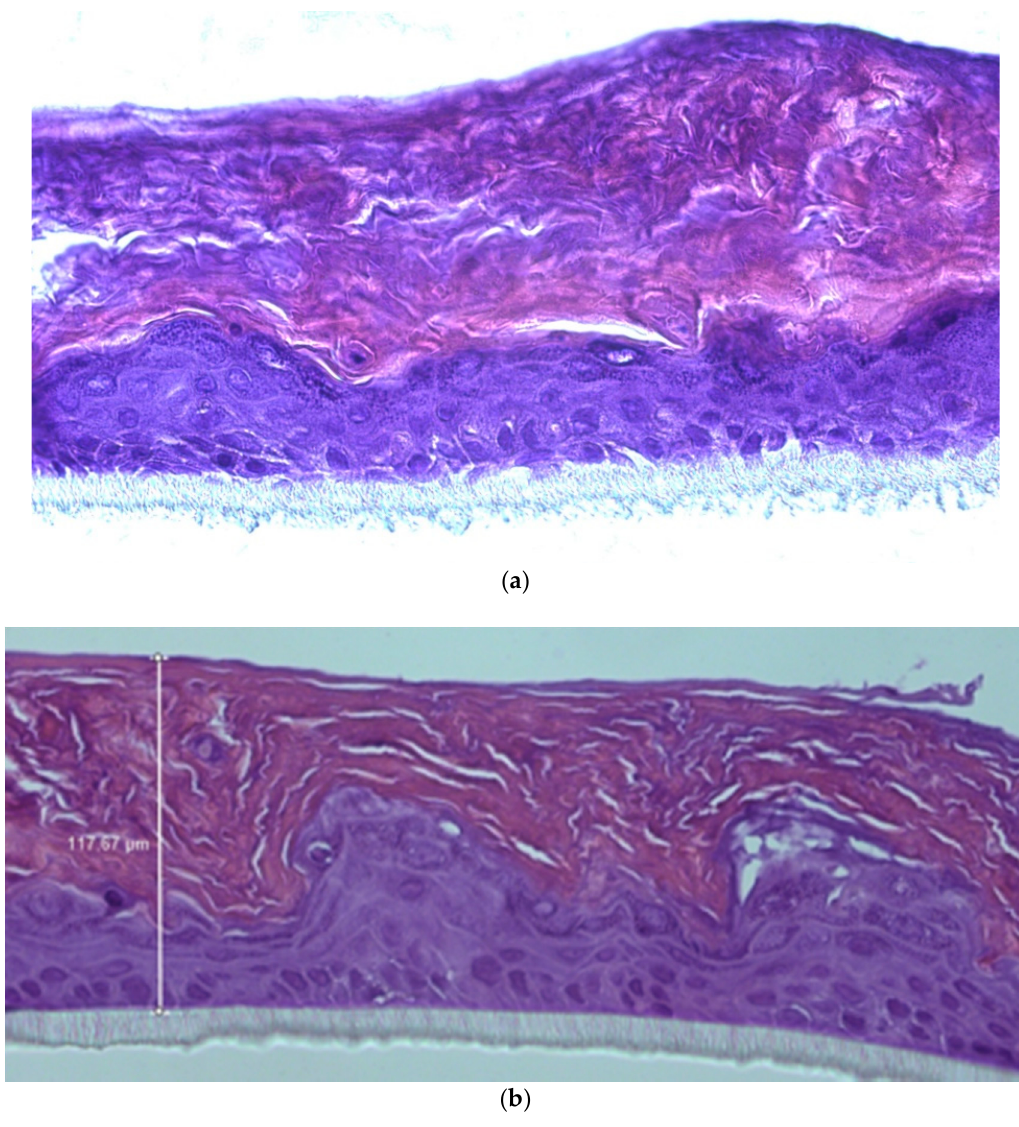
Figure 7. ( a ) morphology of the RHE tissue reference injured; ( b ) injured RHE treated with the finished product (15 µL, 6 h). Enhanced SC lamellar structure and thickness are visible.